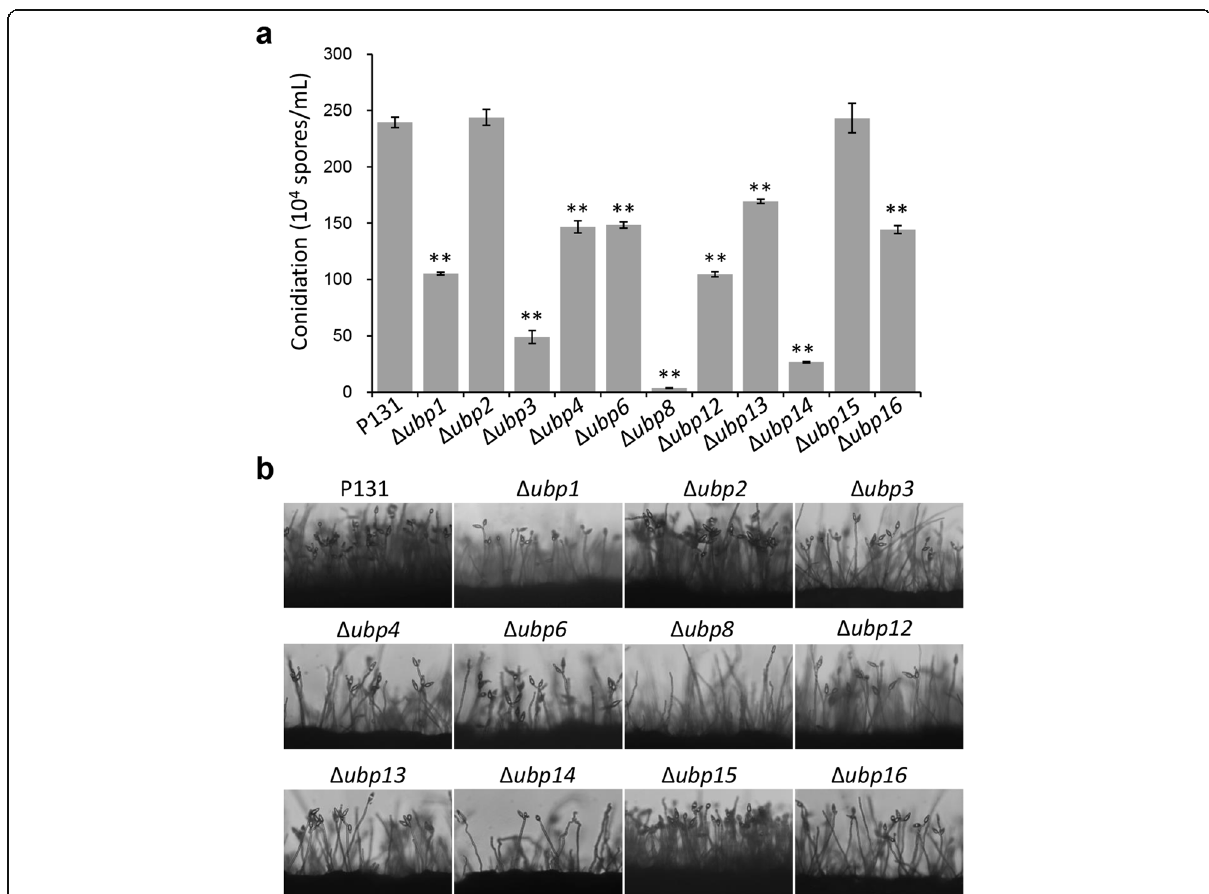
Fig. 5 Asexual development of the ubp mutants. a Conidiation capacity. Conidia were collected from strains growing on OTA plates ( Φ = 6 cm). Means and standard errors were calculated from three independent experiments ( n > 100). Significant differences compared with the wild type are indicated by asterisks ( P < 0.01). b Conidiophore development was observed under light